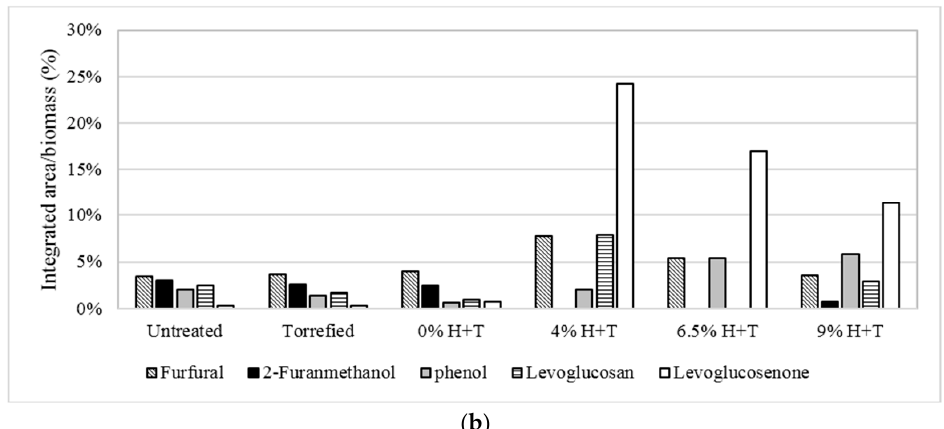
Figure 4. ( a ) Chemical component distributions of bio-oil produced from fast pyrolysis of treated and untreated Phragmites australis ; ( b ) Relative concentration of selected bio-oil compounds from various chemical groups.